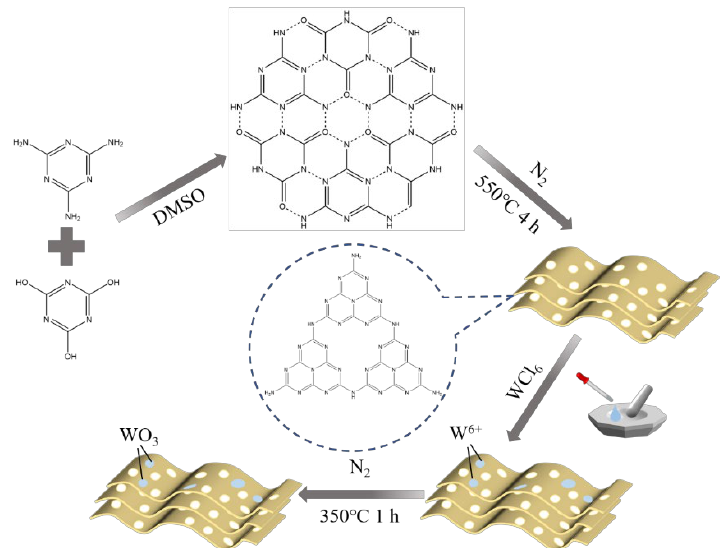
Figure 1. The typical synthetic procedure of MCA-CN/WO 3